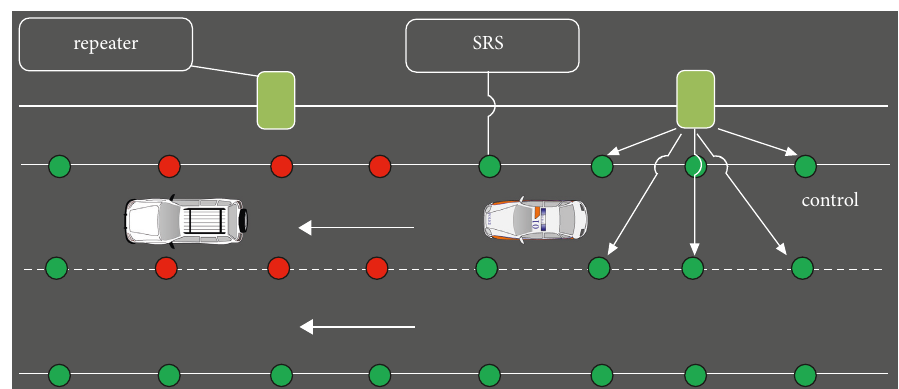
Figure 1: A typical working scenario of the SRS system.